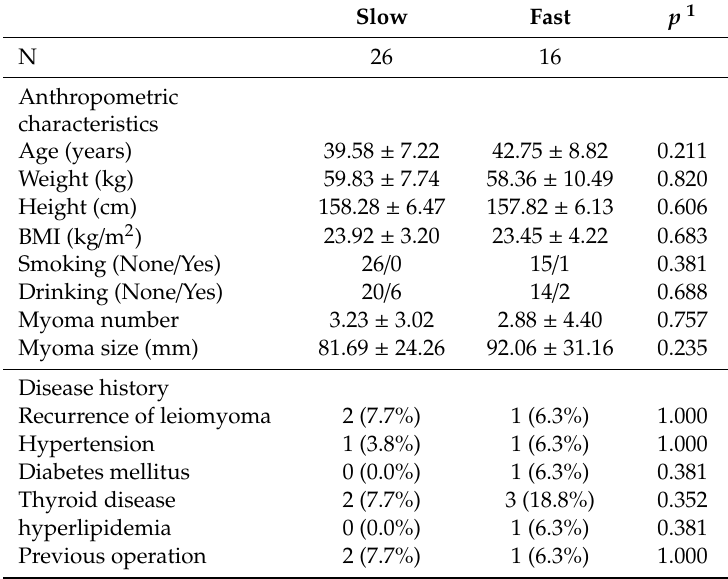
Table 1. Anthropometric and clinical characteristics of the slow and fast groups.